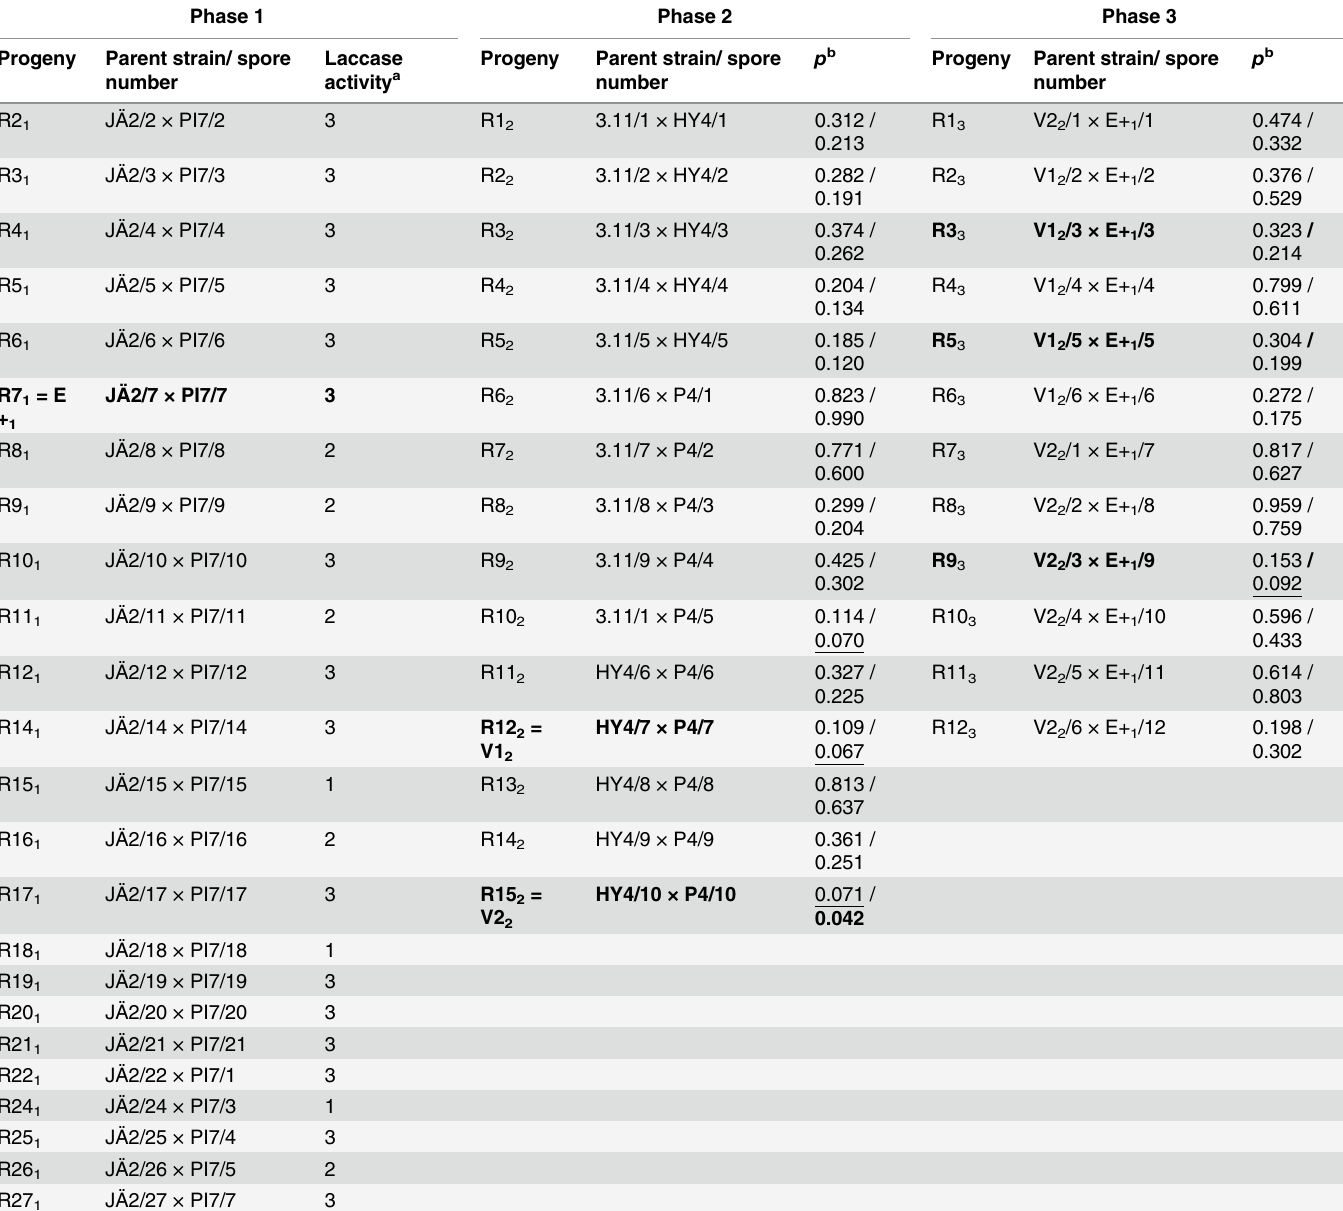
Table 2. Breeding Process of the